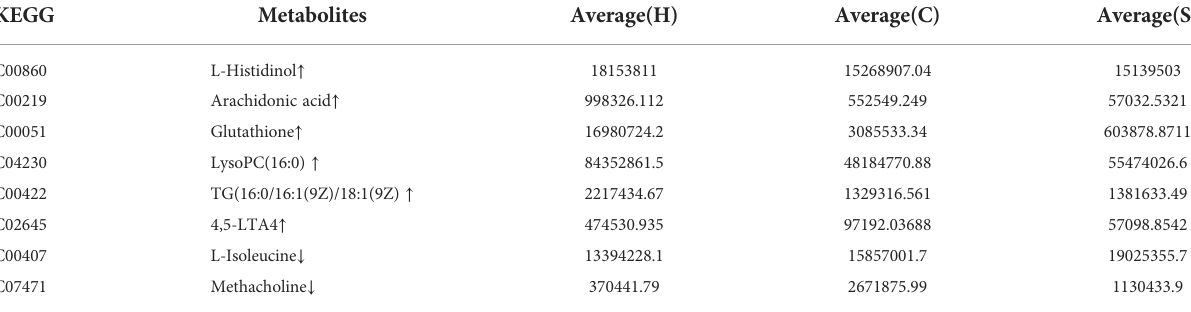
TABLE 3 The up-regulated and down-regulated metabolites in the HFD group were altered by semaglutide.